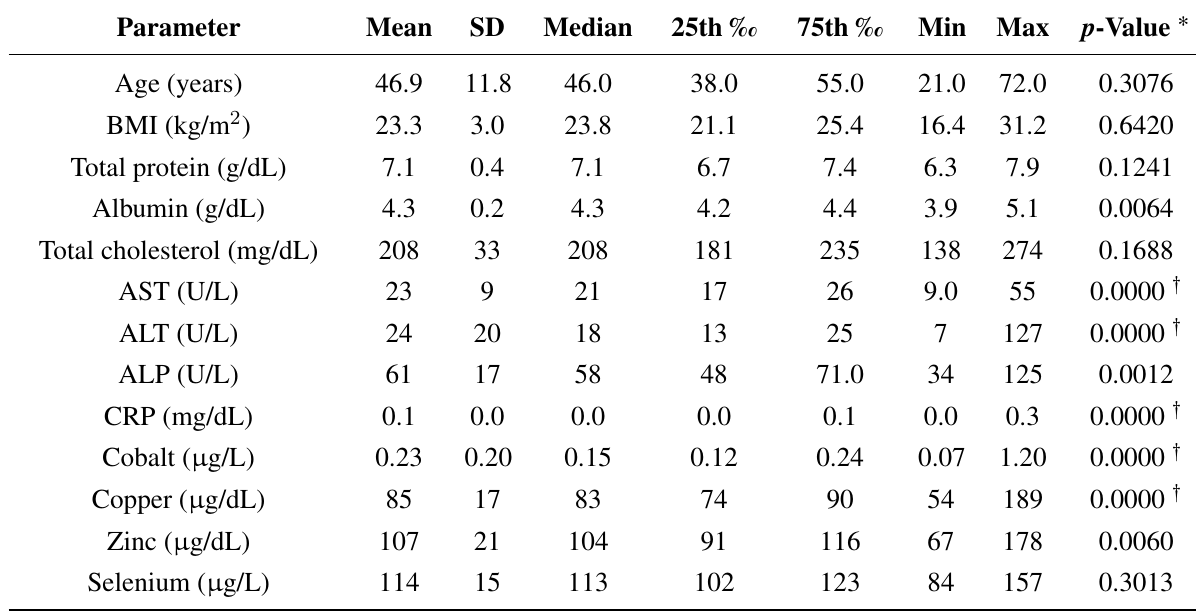
Table 1. Demographic characteristics and trace element concentrations in the control group without pulmonary tuberculosis ( n = 79).